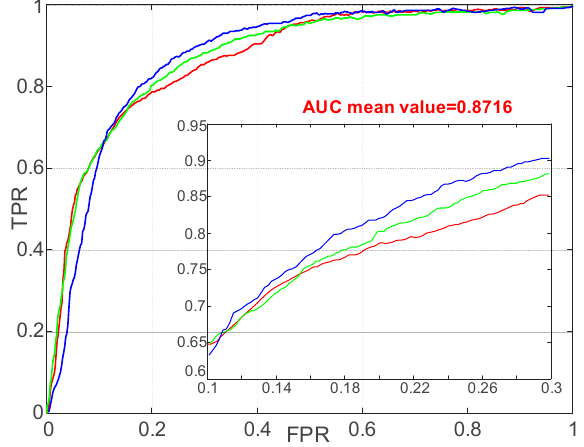
Figure 10. ROC curve detected by back-propagation neural network with K-SMOTE.